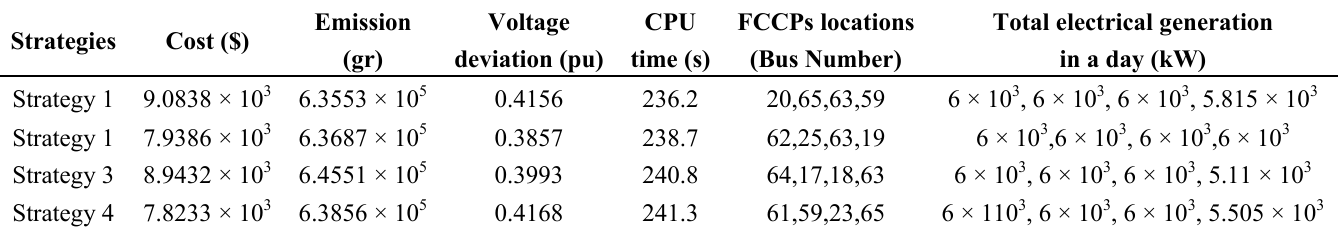
Table 7. Results of best compromise solution for multi objective optimization.